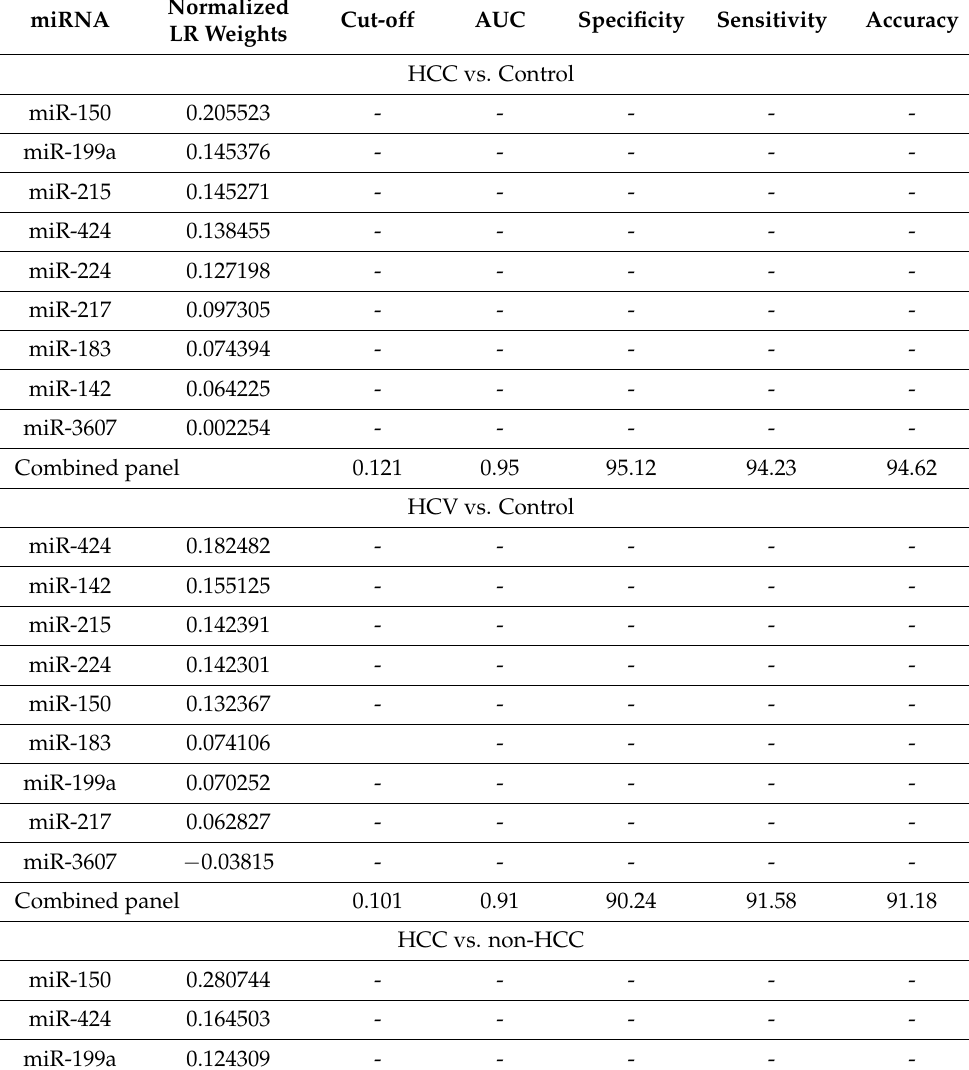
Table 8. Using logistic regression analysis, predict the probability of single and combined miRNAs in HCC patients relative to healthy controls, HCV, and non-HCC